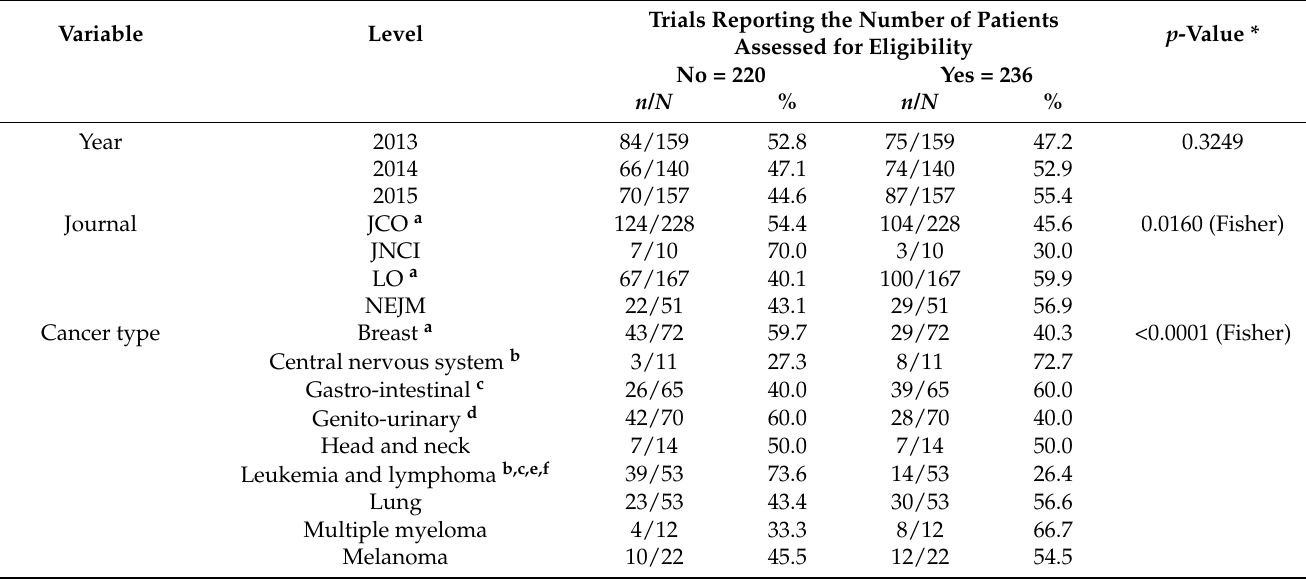
Table 4. Bivariate analyses of variables affecting the reporting of the number of patients assessed for